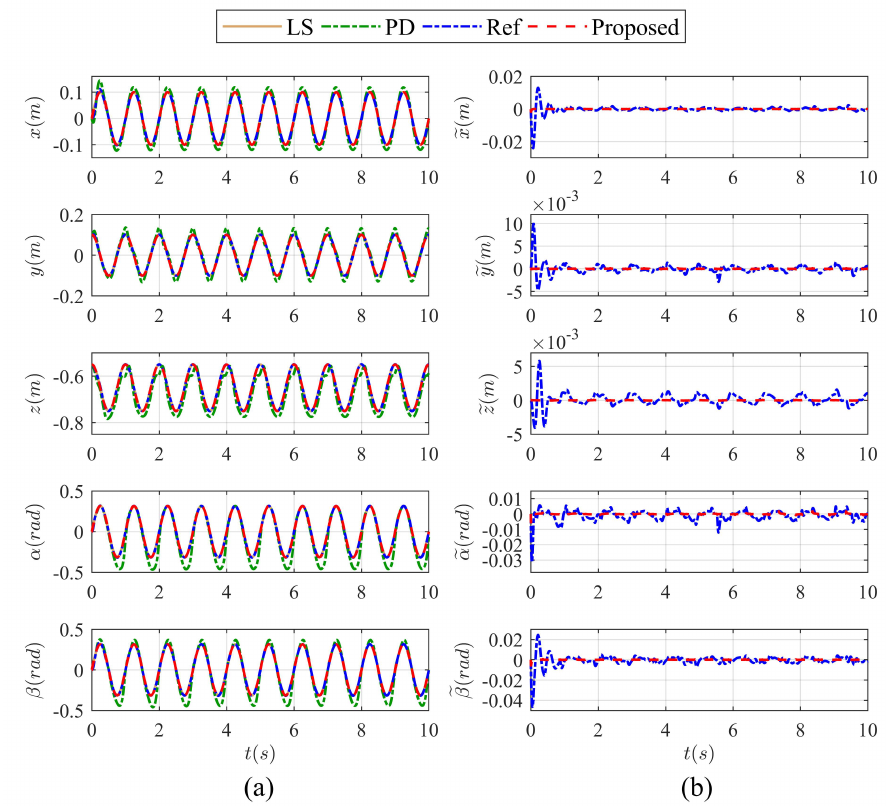
Figure 11. Tracking performance of the generalized coordinates of the 5-DoF spatial PM for case 1: ( a ) comparison of trajectory tracking with different controllers and ( b ) comparison of tracking error between the dynamic feedforward controller and proposed